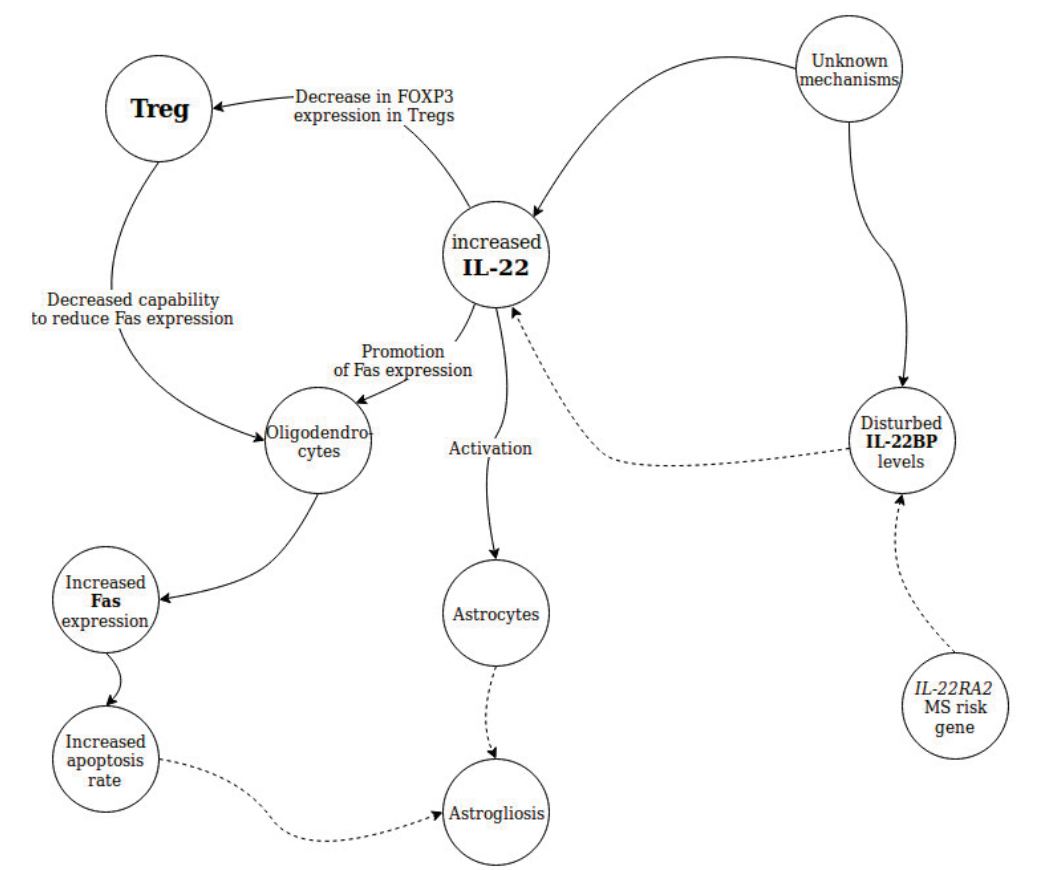
Fig. 1. The role of IL-22 in the course of MS is still ambiguous and not fully understood. This scheme shows the experimentally-proven (continued line) and hypothetical (dashed line) effects of IL-22 in MS.